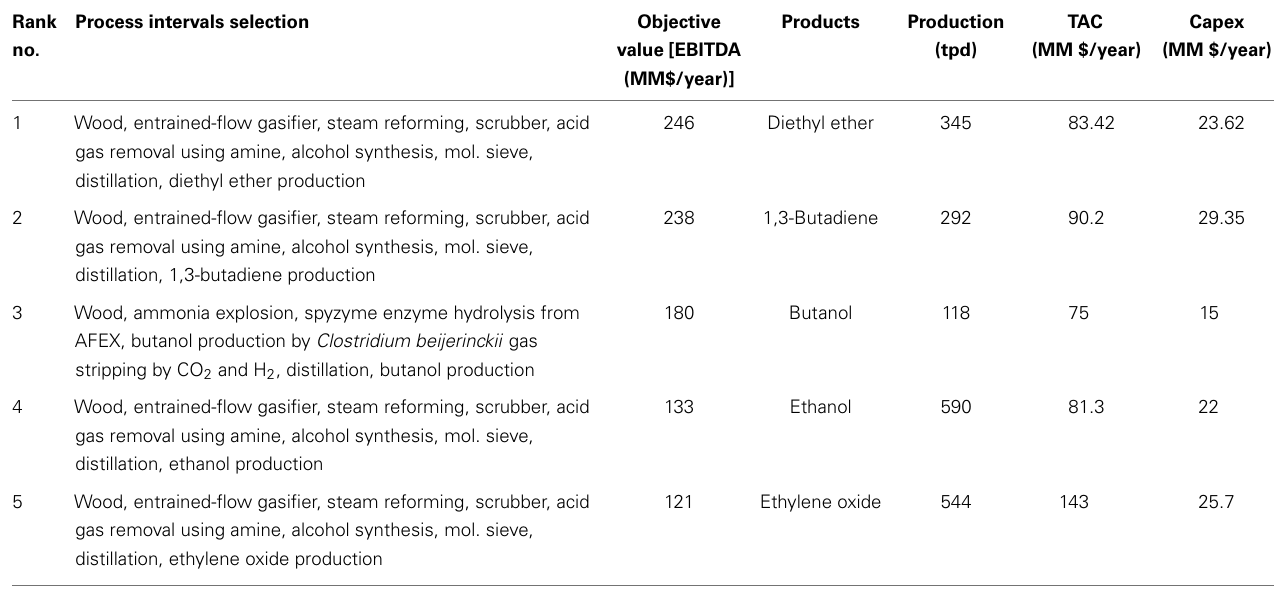
Table 8 |Top-five ranking of the optimal solutions using Model 1 ( + 30 to + 100%) for capital cost estimation (max EBITDA of producing ethanol derivatives) .